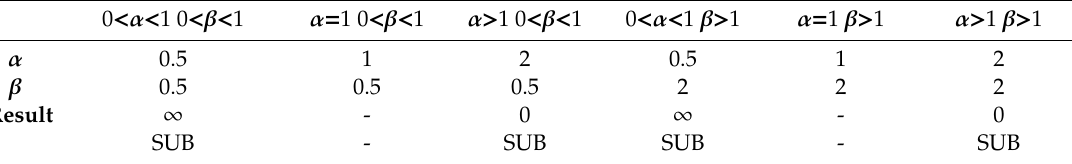
Table 3. Example of subadditivity according to the values of α and β . Source: Own elaboration. 0 < α < 1 0 < β < 1